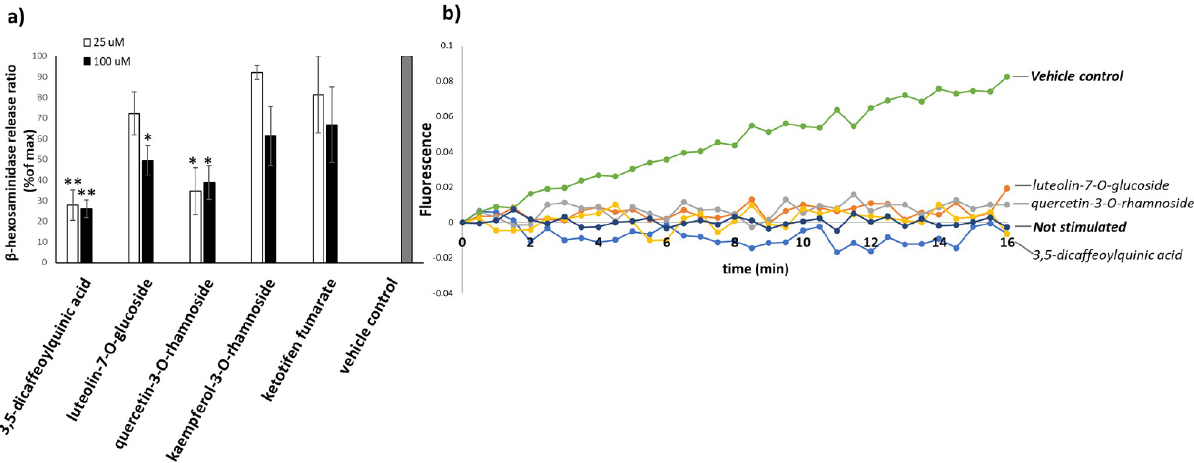
Fig 6. Inhibitory effects on compound 48/80-stimulated RBL-2H3 cell degranulation. a) The effects of the active compounds and ketotifen fumarate (25 and 100 μ M) on β -hexosaminidase release. Ketotifen fumarate was used as a positive control. The values are present as means ± SEM (n = 4). � p < 0.05 and �� p < 0.001, compared with the vehicle control. b) The effects of active compounds (25 μ M) derived from X . tridentata on intracellular ROS generation.